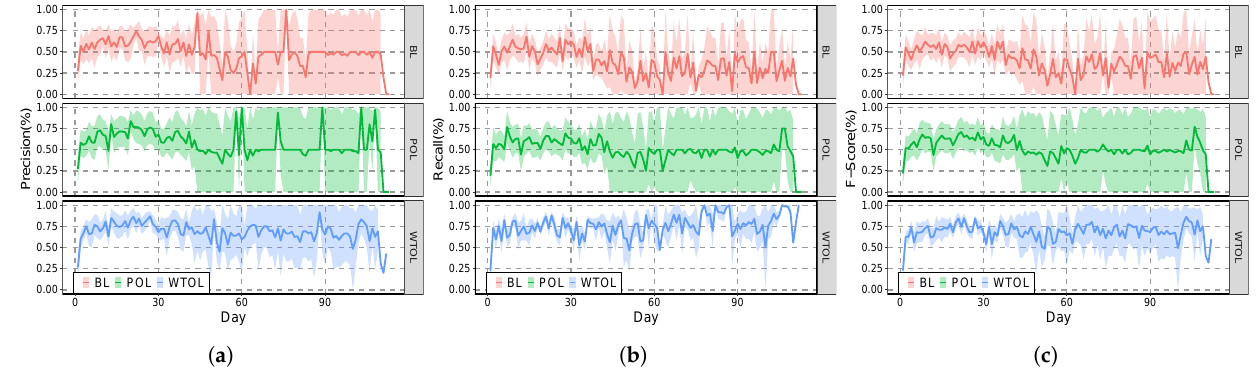
Figure 3. The inference results over time: ( a ) precision; ( b ) recall; and ( c ) F-score.